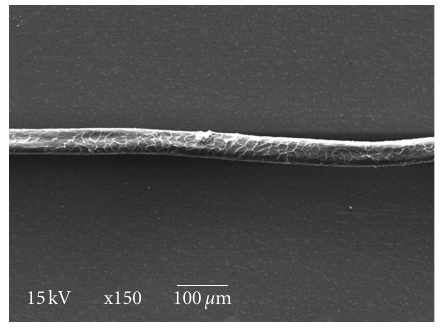
Figure 5: Treated blackish brown wool fiber ( ×